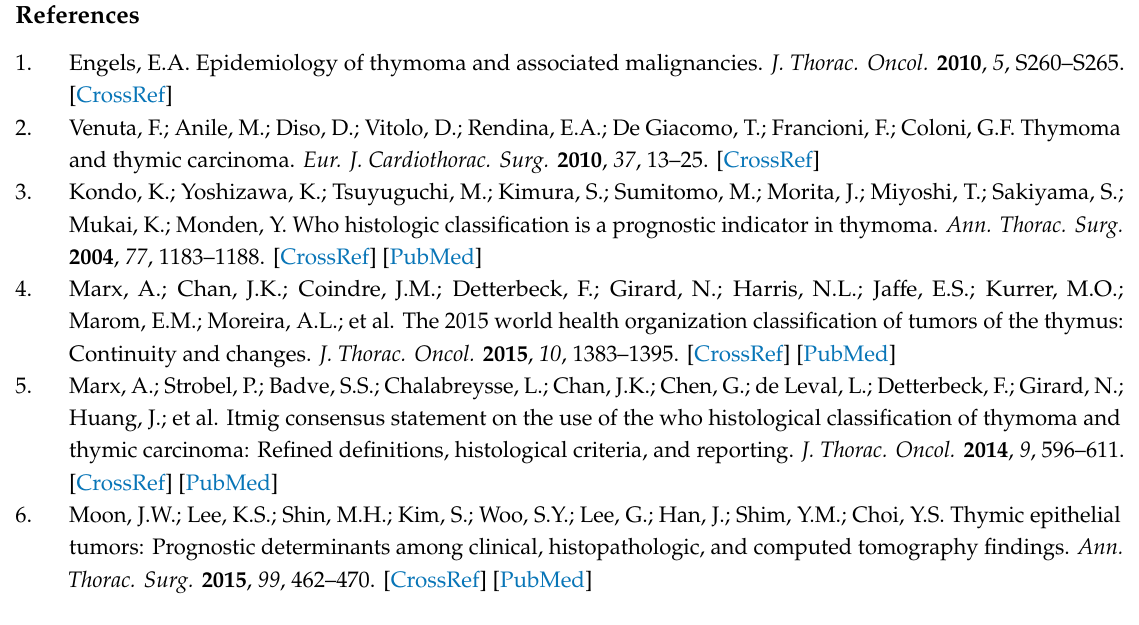
Table S1: Detailed clinicopathological features and immunophenotypic data of individual